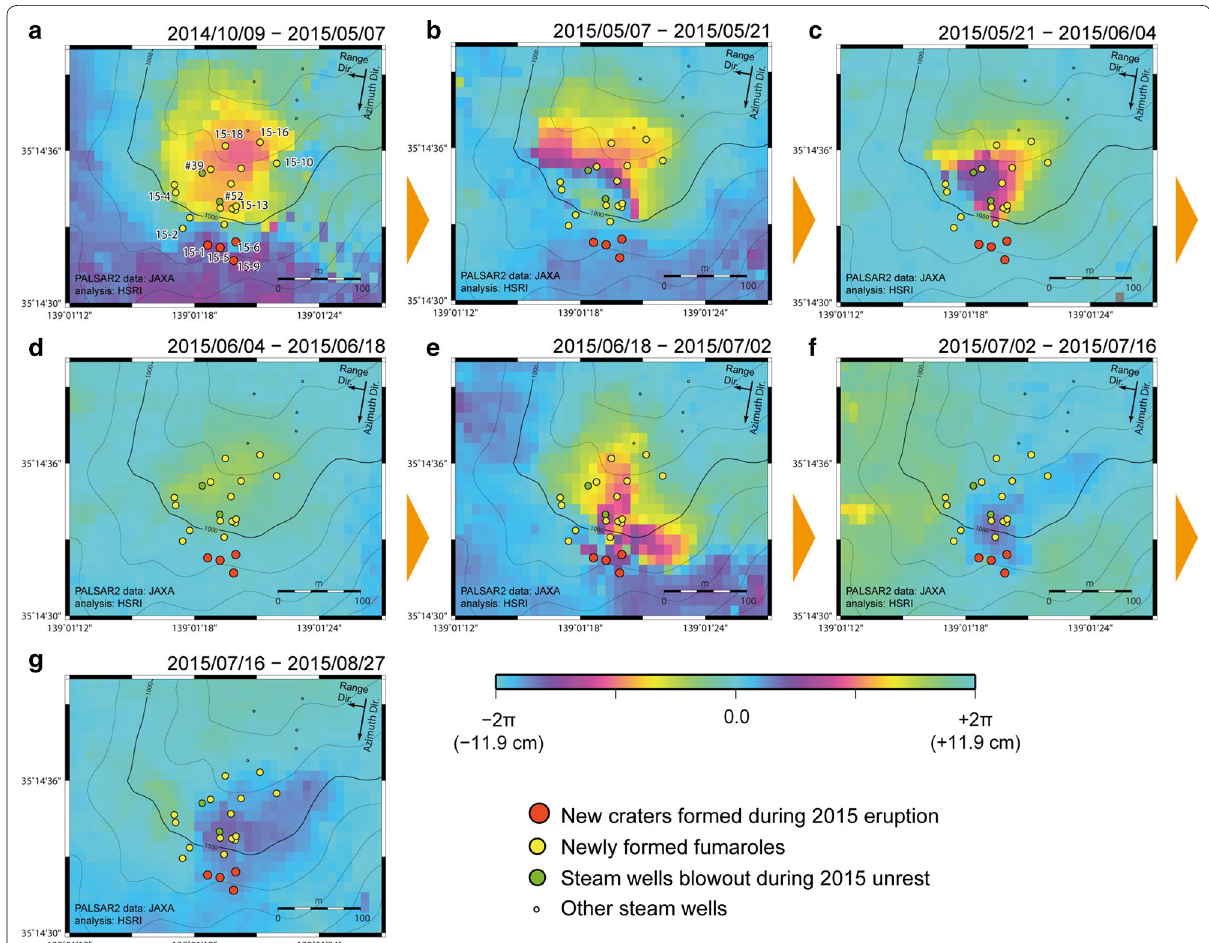
Fig. 3 Temporal change of local swelling at Owakudani (modified from Doke et al. 2015a). Interferograms are obtained from InSAR pairs in the same orbit with Pair I (Path 18). Color shows wrapped phase difference between 0 and slant-range change of 11.9 cm. Contour intervals are 25 m in